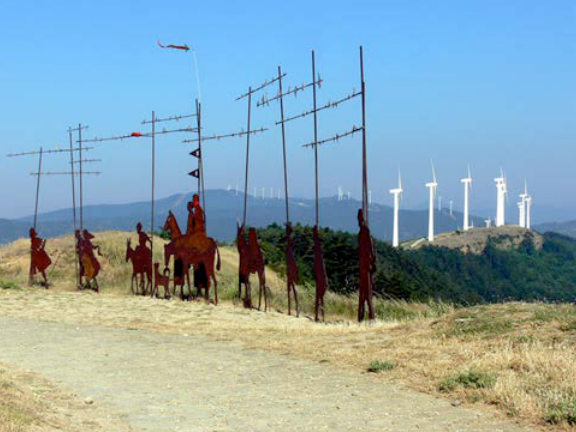
Figure 2. The wind farm as seen from the Way of St. James on top of the Alto del Perdón.